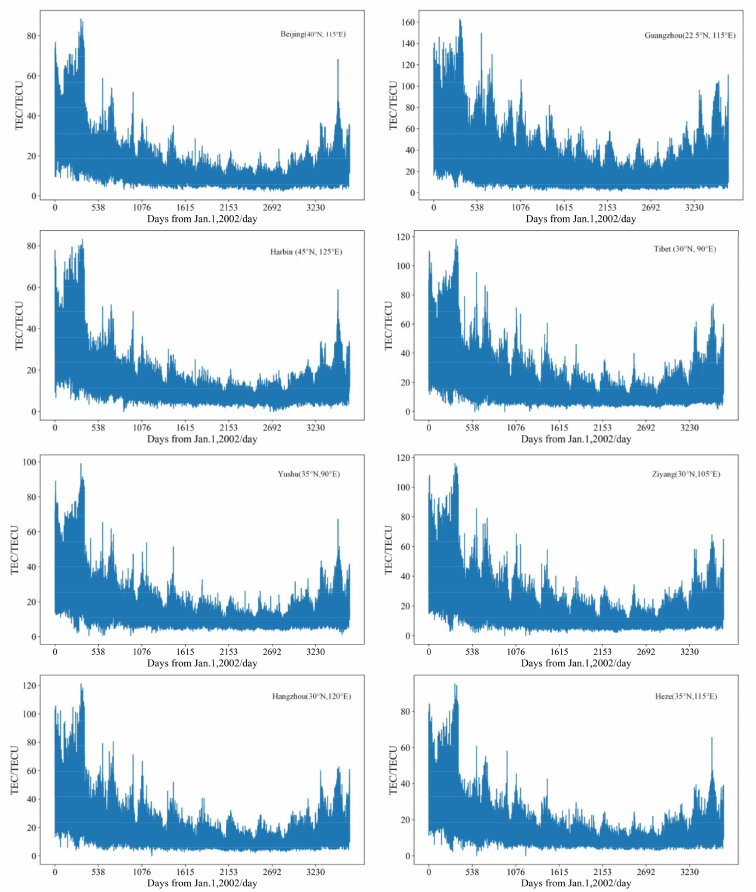
Figure 2. TEC data of eight regions selected in this